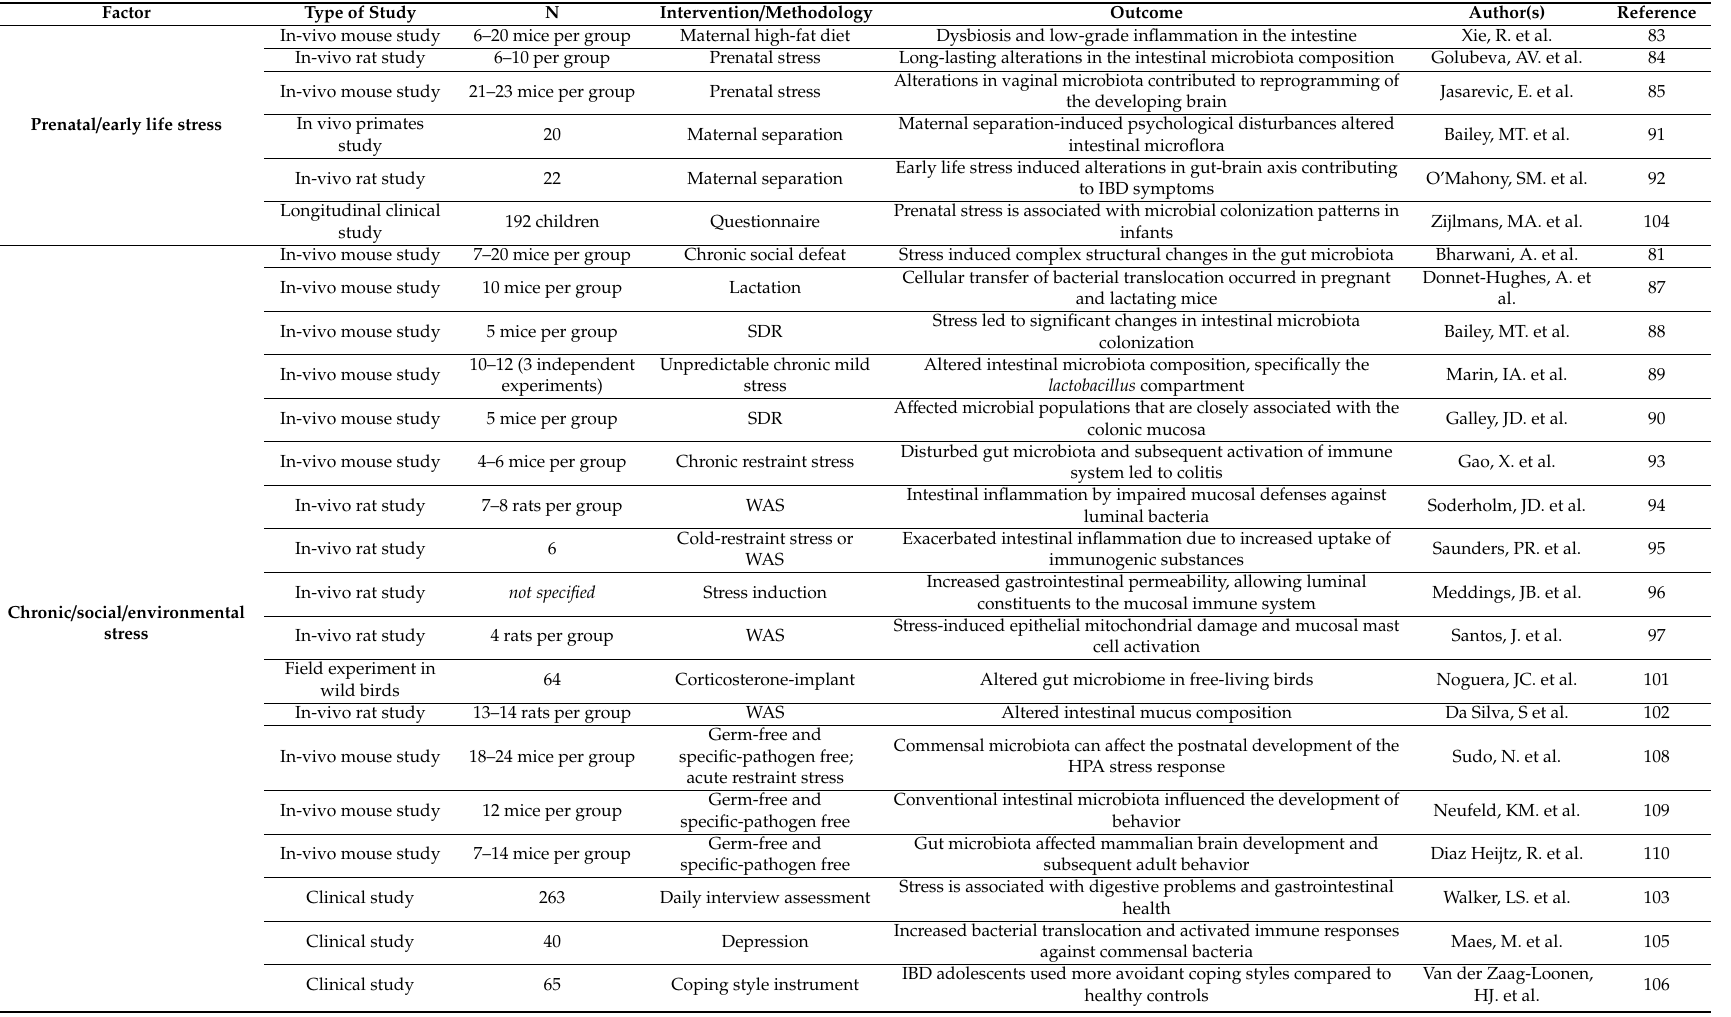
Table 2. Studies investigating the link between stress and gut